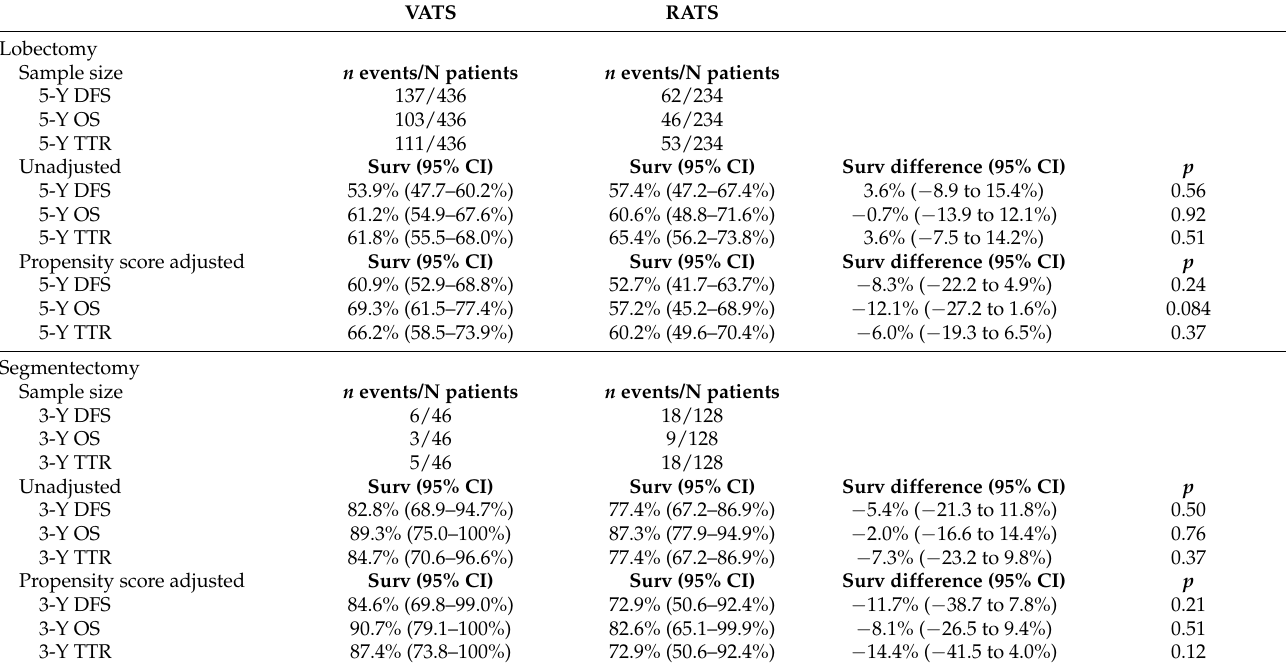
Table 2. Long-term survival results of patients who had lobectomy and segmentectomy, according to VATS and RATS procedure.